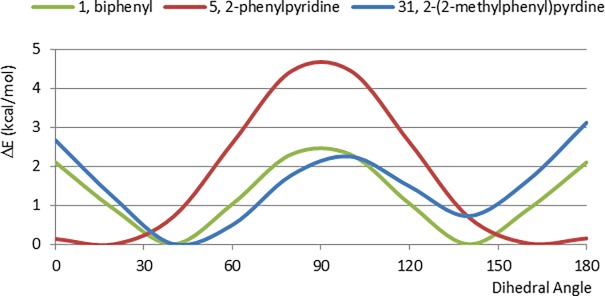
Comparison between biphenyl 1, 2-phenylpyridine 5 and 2-(2-methylphenyl)-pyridine 31.